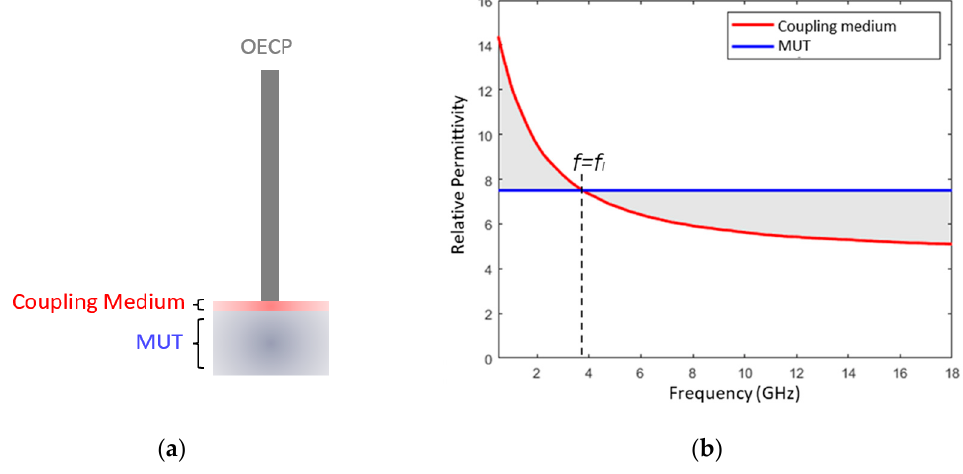
Figure 2. Relative permittivity measurement with coupling medium application: ( a ) schematic representation of the sensing volume of the OECP; ( b ) range of the relative permittivity expected to be measured with coupling medium application over MUT. The sensing volume of the OECP comprises a heterogeneous material formed by two layers: the coupling medium, in direct contact with the probe; and the MUT underneath. The graph illustrates the resulting relative permittivity range expected to be measured (shaded band), where the dielectric properties of heterogeneous material vary between the dielectric properties of the two individual materials present in the sensing volume of the probe. The dielectric properties of the coupling medium and MUT are described by the red and blue curves, respectively, and overlap for the intersection frequency, f = f I .